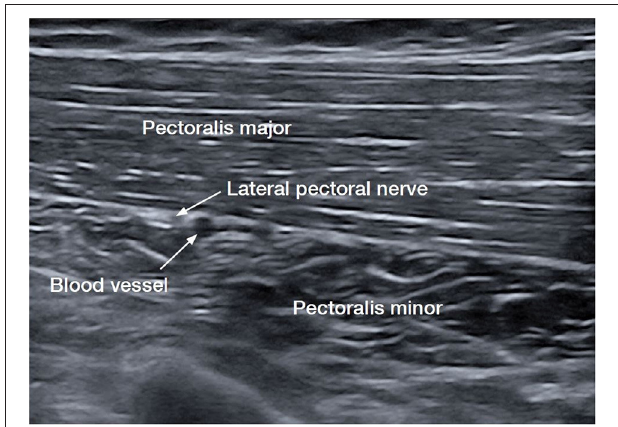
FIGURE 2 | Ultrasound image of the lateral pectoral nerve (LPN), the dominant nerve of the pectoralis major muscle (PMM) (15, 16).